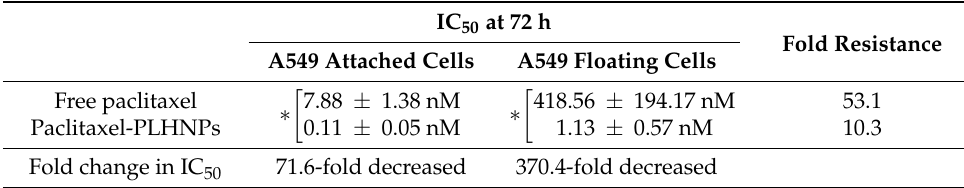
Table 2. IC 50 values of paclitaxel in A549 attached and A549 floating cells. * p < 0.05 compared to free